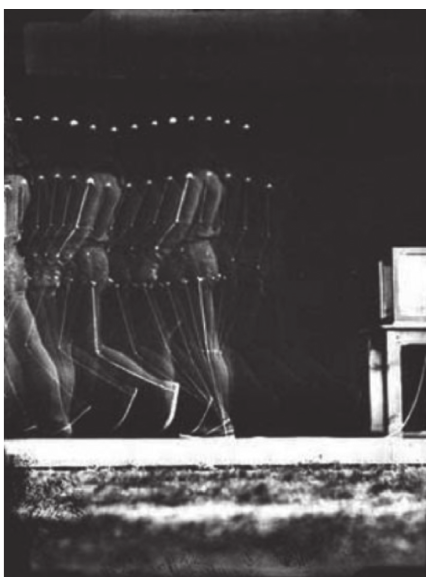
Figure 4: The man walking (1890) by Etienne-Jules Marey [4].